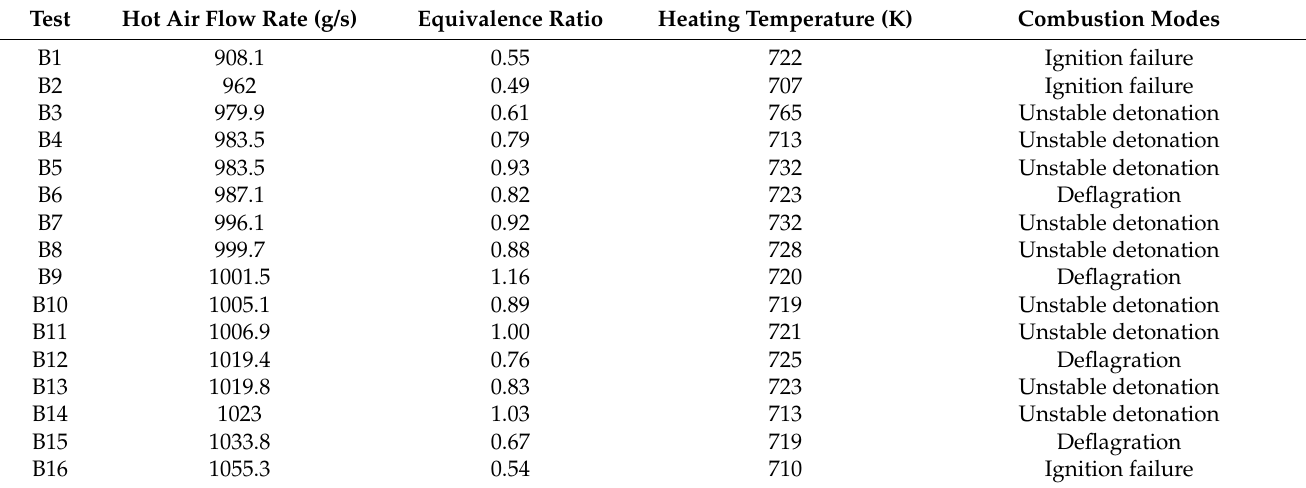
Table 3. Experimental conditions with air